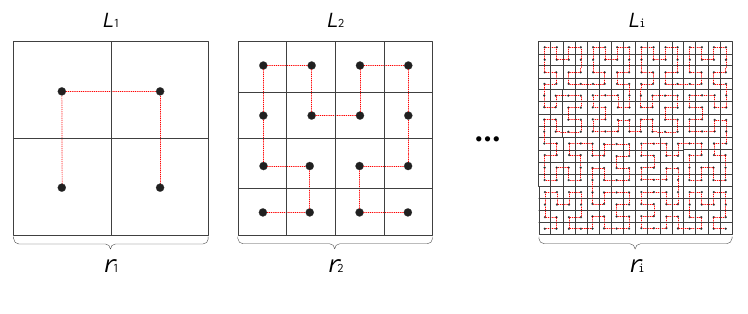
Figure 4. Hierarchical space partition schema.